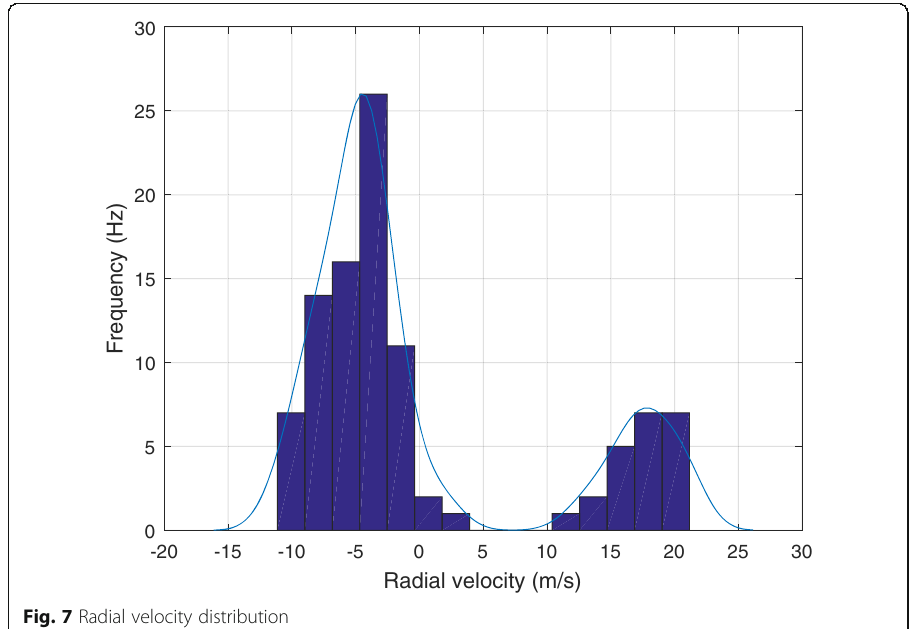
Fig. 7 Radial velocity distribution